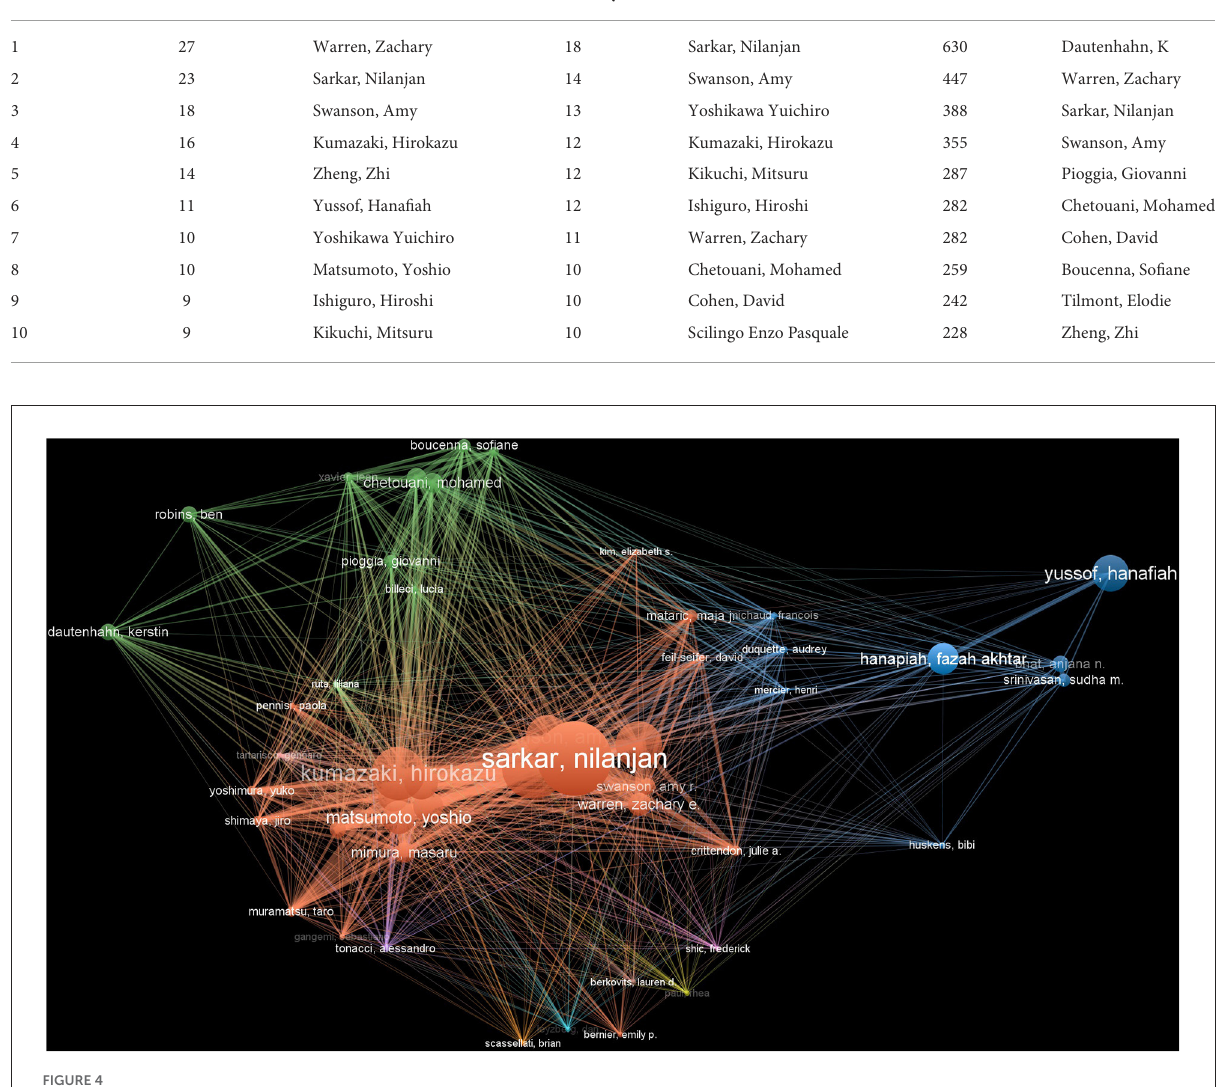
FIGURE4 The collaboration network of authors related to Al on